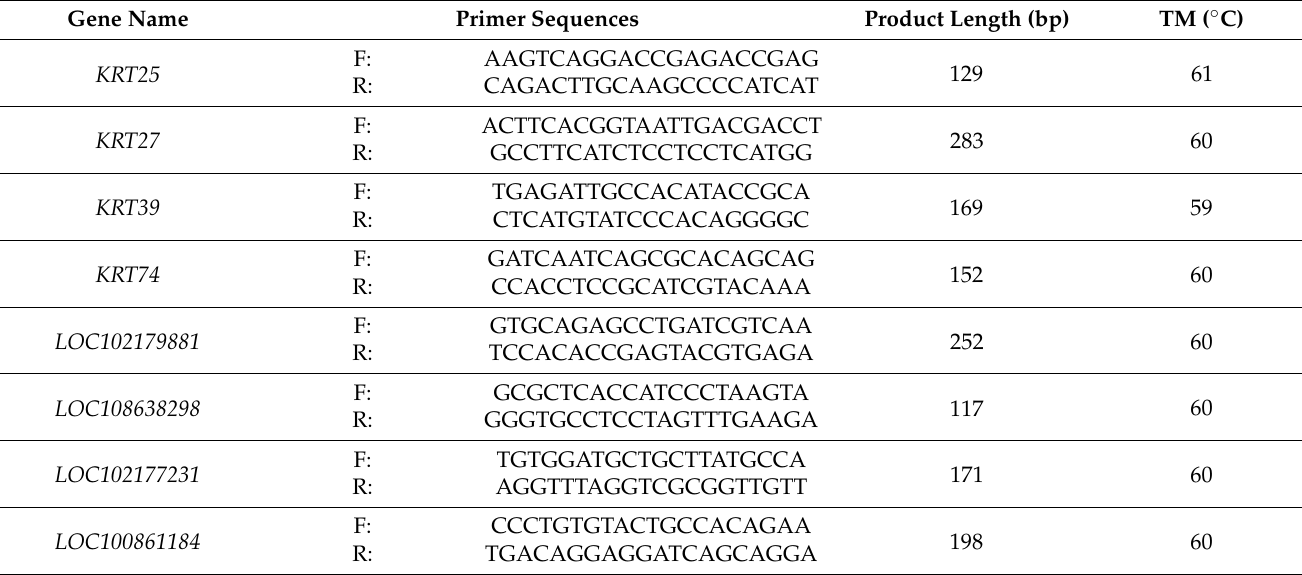
Table 1. Primer sequences of candidate genes and reference